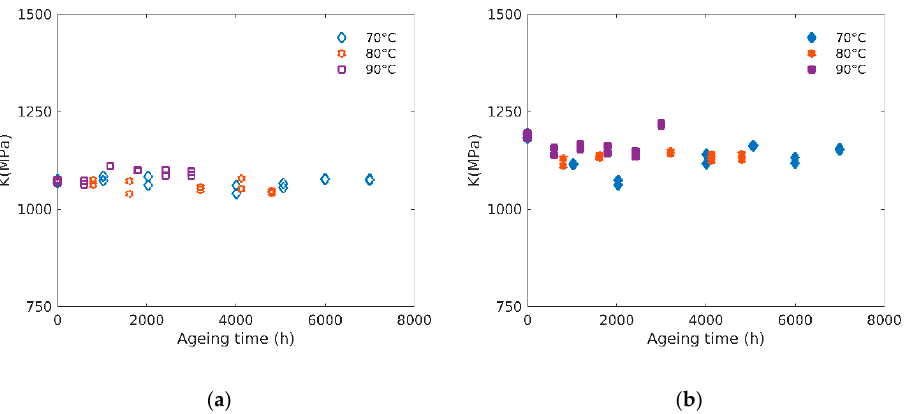
Figure 8. ( a ) Evolution of the bulk modulus ( K ) with ageing time for unfilled and ( b ) filled rubbers at 70 °C, 80 °C and 90 °C.